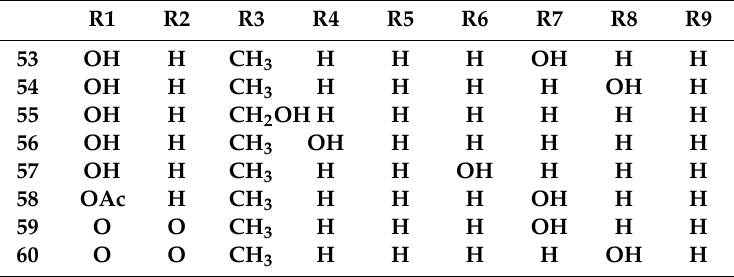
Table 1. The chemical structures of compound 53 – 60